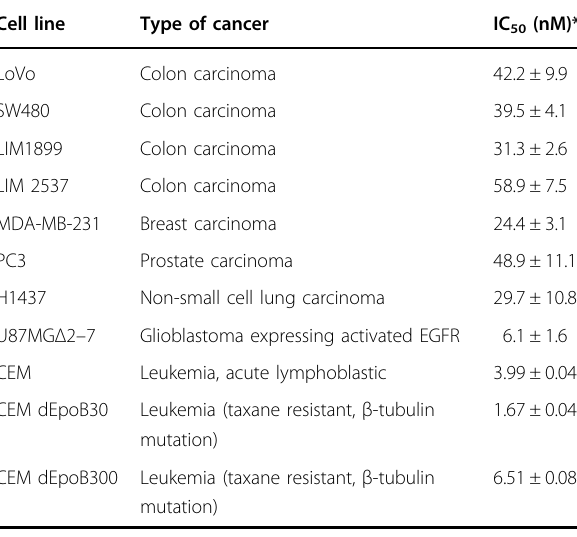
Table 1 Inhibition of cellular proliferation by WEHI-7326: a panel of cancer cell